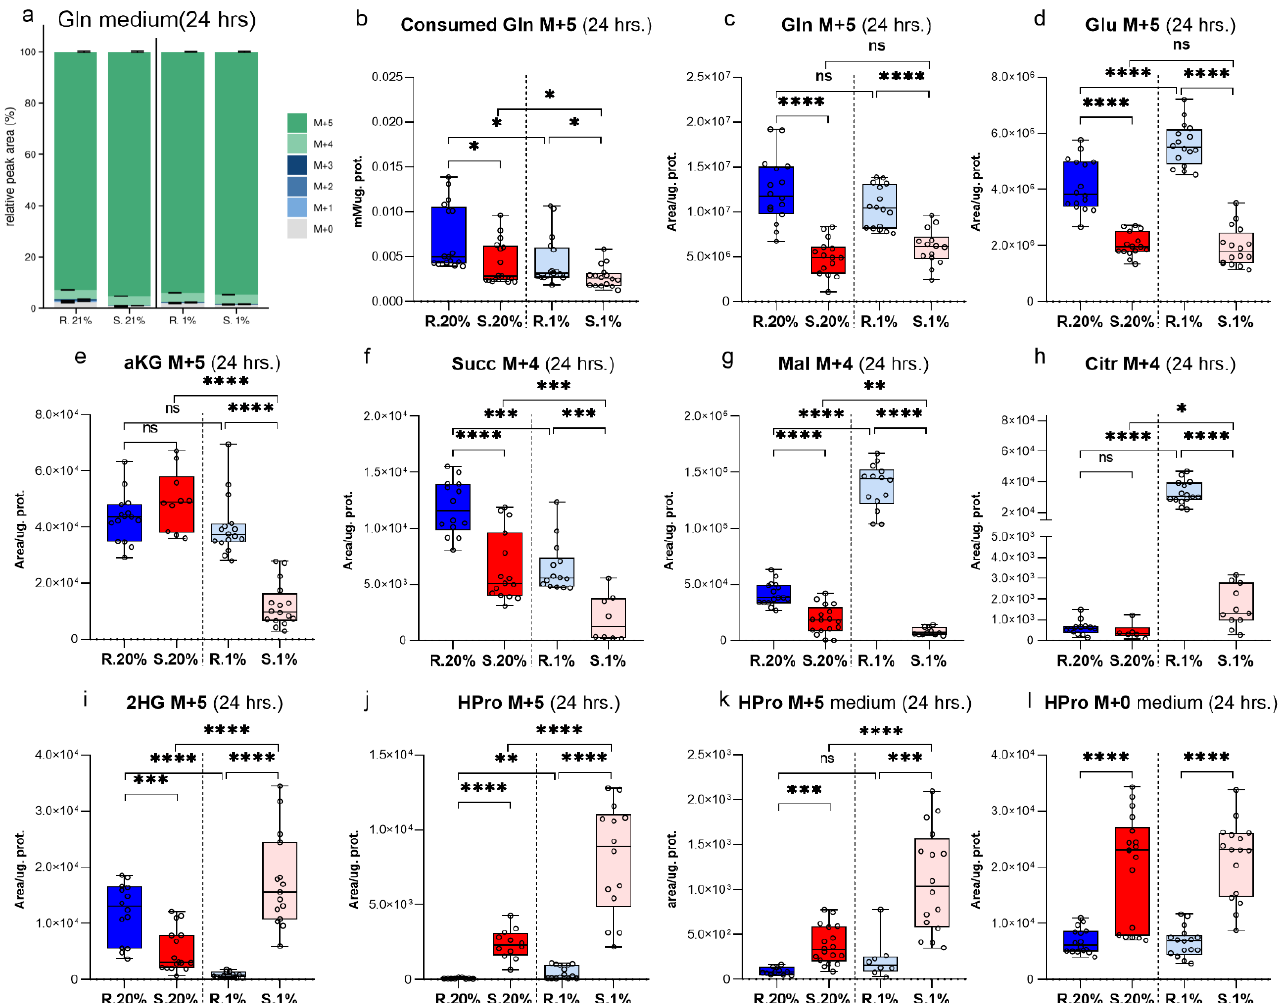
Figure 1. Selected characteristics of Gln homeostasis in the Spalax and rat cells after one day under normoxia and hypoxia: ( a ) the MID for medium Gln, ( b ) the Gln M+5 that was consumed by the cells ( c ), ( d )-intracellular levels of Gln M+5 and Glu M+5; the levels of the TCA cycle Gln-derived intermediates: ( e – h ) the levels of intracellular α KG M+5, succinate M+4, malate M+4, citrate M+4, Orn M+5, HPro M+5; and the fate of diverted from the TCA cycle Gln M+5: ( i , j ) intracellular levels of 2HG M+5, HPro M+5; ( k , l ), secreted outside HPro M+5, HPro M+0. S.20%, R. 20%, S.1%, R1% represents Spalax (S) and rat (R) cells that were exposed to an atmosphere containing 20% or 1% O 2 , respectively; ns, (nonsignificant) p > 0.05; * p < 0.05; ** p < 0.01; *** p < 0.001; **** p < 0.0001, the error bars represent standard deviation of six or more biological repeats. Every point on the chart represents one technical